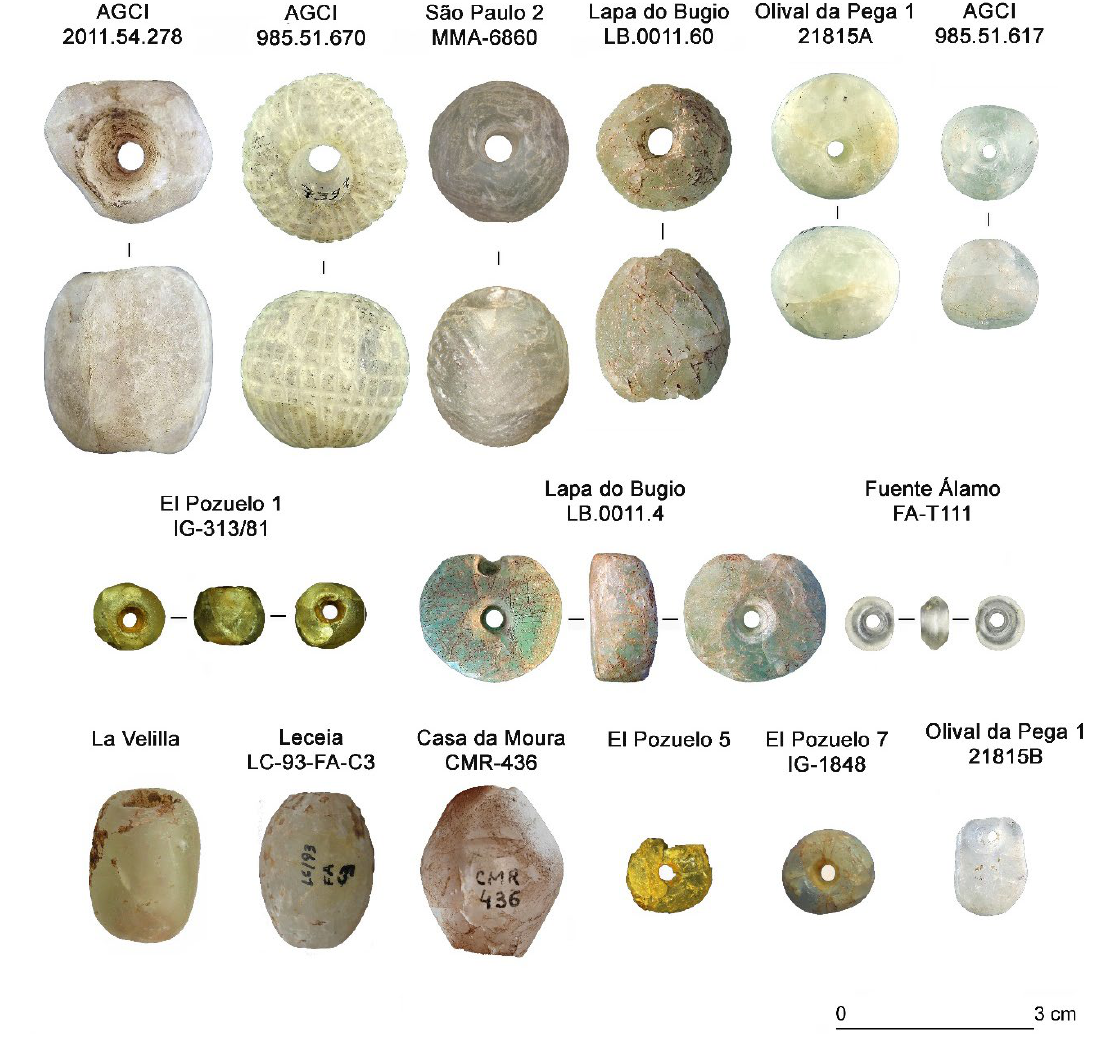
Figure 2. A sample of beads analyzed in this